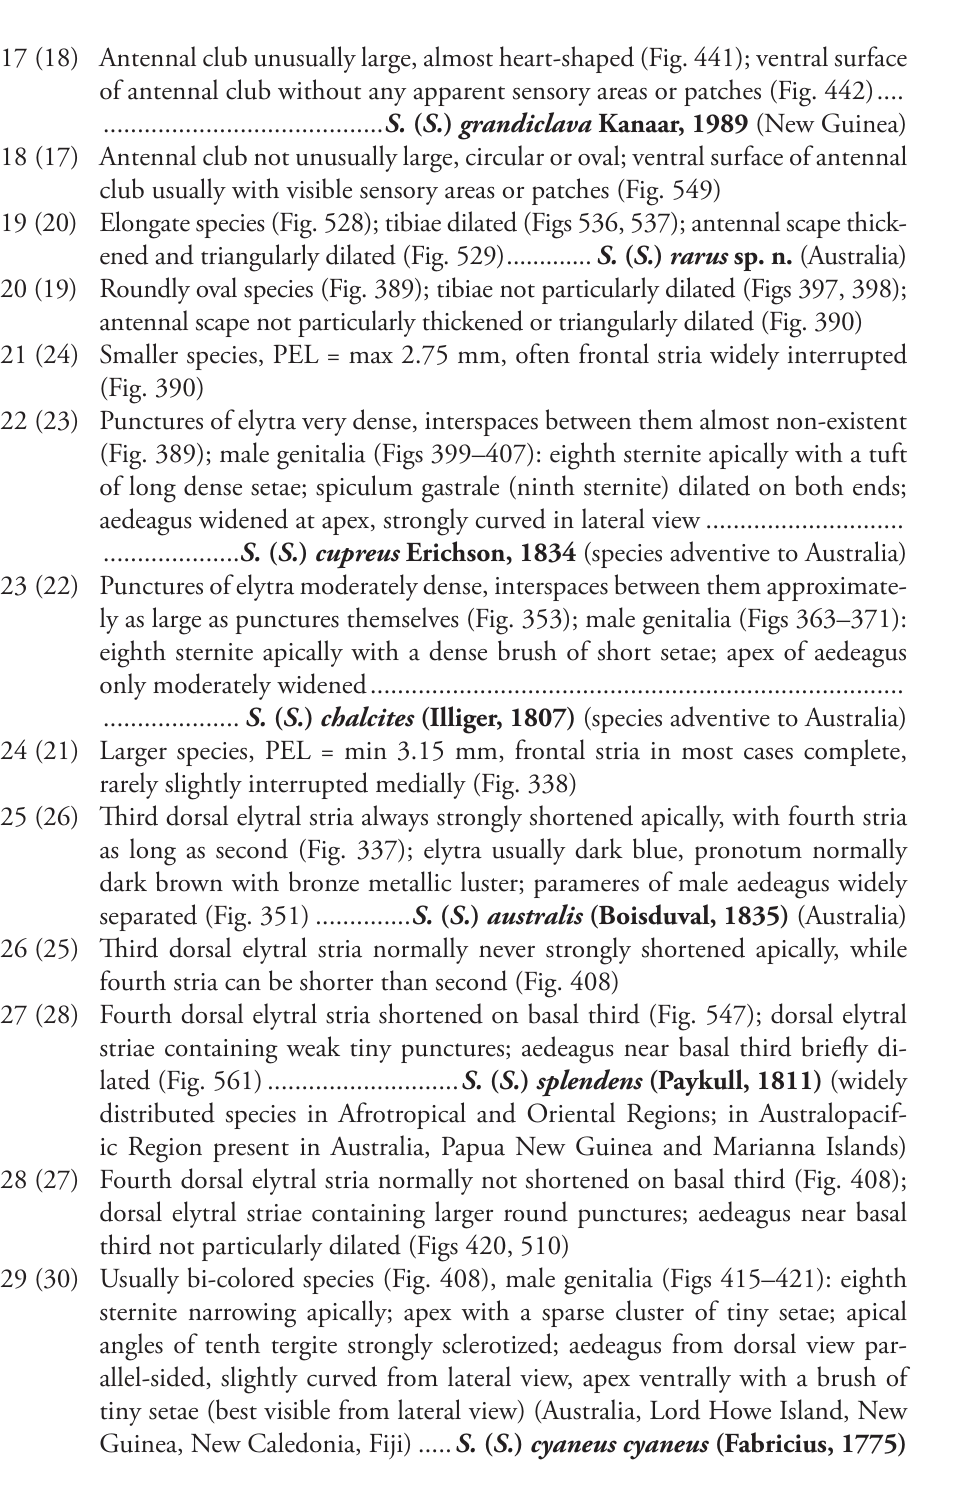
17 (18) Antennal club unusually large, almost heart-shaped (Fig. 441); ventral surface of antennal club without any apparent sensory areas or patches (Fig. 442) .... ......................................... S. ( S. ) grandiclava Kanaar, 1989 (New Guinea) 18 (17) Antennal club not unusually large, circular or oval; ventral surface of antennal club usually with visible sensory areas or patches (Fig. 549) 19 (20) Elongate species (Fig. 528); tibiae dilated (Figs 536, 537); antennal scape thick- ened and triangularly dilated (Fig. 529) ............. S. ( S. ) rarus sp. n. (Australia) 20 (19) Roundly oval species (Fig. 389); tibiae not particularly dilated (Figs 397, 398); antennal scape not particularly thickened or triangularly dilated (Fig. 390) 21 (24) Smaller species, PEL = max 2.75 mm, often frontal stria widely interrupted (Fig. 390) 22 (23) Punctures of elytra very dense, interspaces between them almost non-existent (Fig. 389); male genitalia (Figs 399–407): eighth sternite apically with a tuft of long dense setae; spiculum gastrale (ninth sternite) dilated on both ends; aedeagus widened at apex, strongly curved in lateral view ............................. .................... S. ( S. ) cupreus Erichson, 1834 (species adventive to Australia) 23 (22) Punctures of elytra moderately dense, interspaces between them approximate- ly as large as punctures themselves (Fig. 353); male genitalia (Figs 363–371): eighth sternite apically with a dense brush of short setae; apex of aedeagus only moderately widened .............................................................................. .................... S. ( S. ) chalcites (Illiger, 1807) (species adventive to Australia) 24 (21) Larger species, PEL = min 3.15 mm, frontal stria in most cases complete, rarely slightly interrupted medially (Fig. 338) 25 (26) Third dorsal elytral stria always strongly shortened apically, with fourth stria as long as second (Fig. 337); elytra usually dark blue, pronotum normally dark brown with bronze metallic luster; parameres of male aedeagus widely separated (Fig. 351) .............. S. ( S. ) australis (Boisduval, 1835) (Australia) 26 (25) Third dorsal elytral stria normally never strongly shortened apically, while fourth stria can be shorter than second (Fig. 408) 27 (28) Fourth dorsal elytral stria shortened on basal third (Fig. 547); dorsal elytral striae containing weak tiny punctures; aedeagus near basal third briefly di- lated (Fig. 561) ............................ S. ( S. ) splendens (Paykull, 1811) (widely distributed species in Afrotropical and Oriental Regions; in Australopacif- ic Region present in Australia, Papua New Guinea and Marianna Islands) 28 (27) Fourth dorsal elytral stria normally not shortened on basal third (Fig. 408); dorsal elytral striae containing larger round punctures; aedeagus near basal third not particularly dilated (Figs 420, 510) 29 (30) Usually bi-colored species (Fig. 408), male genitalia (Figs 415–421): eighth sternite narrowing apically; apex with a sparse cluster of tiny setae; apical angles of tenth tergite strongly sclerotized; aedeagus from dorsal view par- allel-sided, slightly curved from lateral view, apex ventrally with a brush of tiny setae (best visible from lateral view) (Australia, Lord Howe Island, New Guinea, New Caledonia, Fiji) ..... S. ( S. ) cyaneus cyaneus (Fabricius,